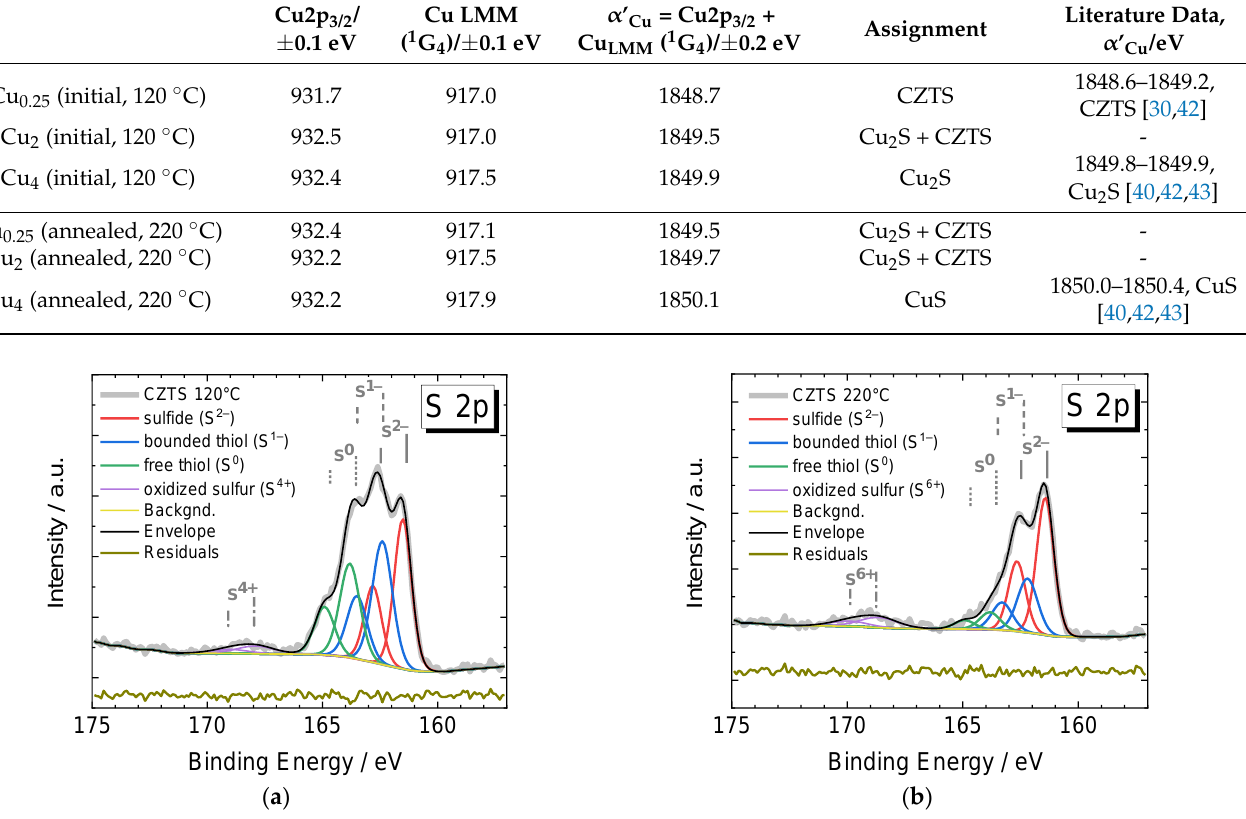
Figure 2. The S2p XPS spectra of CZTS NC Cu 4 films in the initial state ( a ) and after annealing in air ( b ).